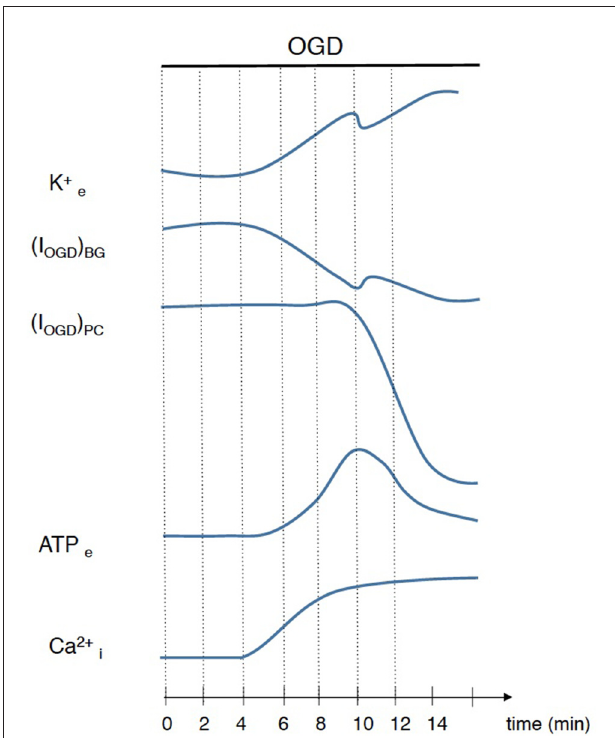
FIGURE 8 | Schematic illustration of events that occur during ischemia simulated by OGD. Interruption of ATP production leads to an imbalance of ionic gradients resulting in an accumulation of K + in extracellular space and consequent Bergmann glia depolarization. This disruption of ion homeostasis depolarizes cerebellar neurons exacerbating glutamate release that, with several minutes of delay, induces a huge depolarization in Purkinje cells. ATP extracellular concentration is also increased during OGD and is responsible, at least in part, for Ca 2 + rises in Bergmann glial